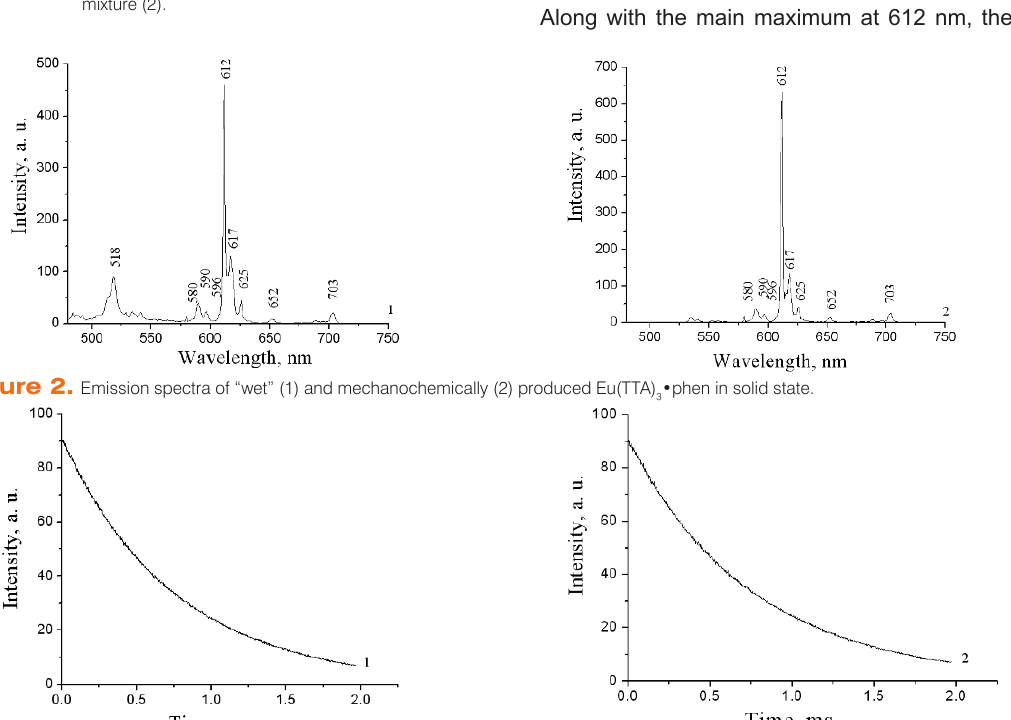
•phen 3 .H O–HTTA-phen 3 2